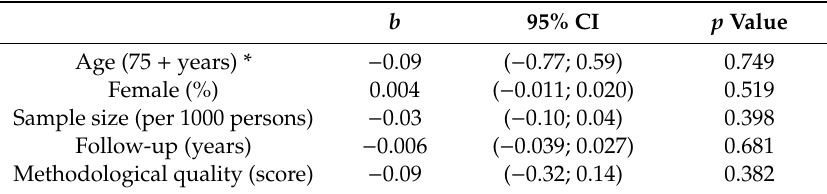
Table 2. Univariate meta-regression results for the